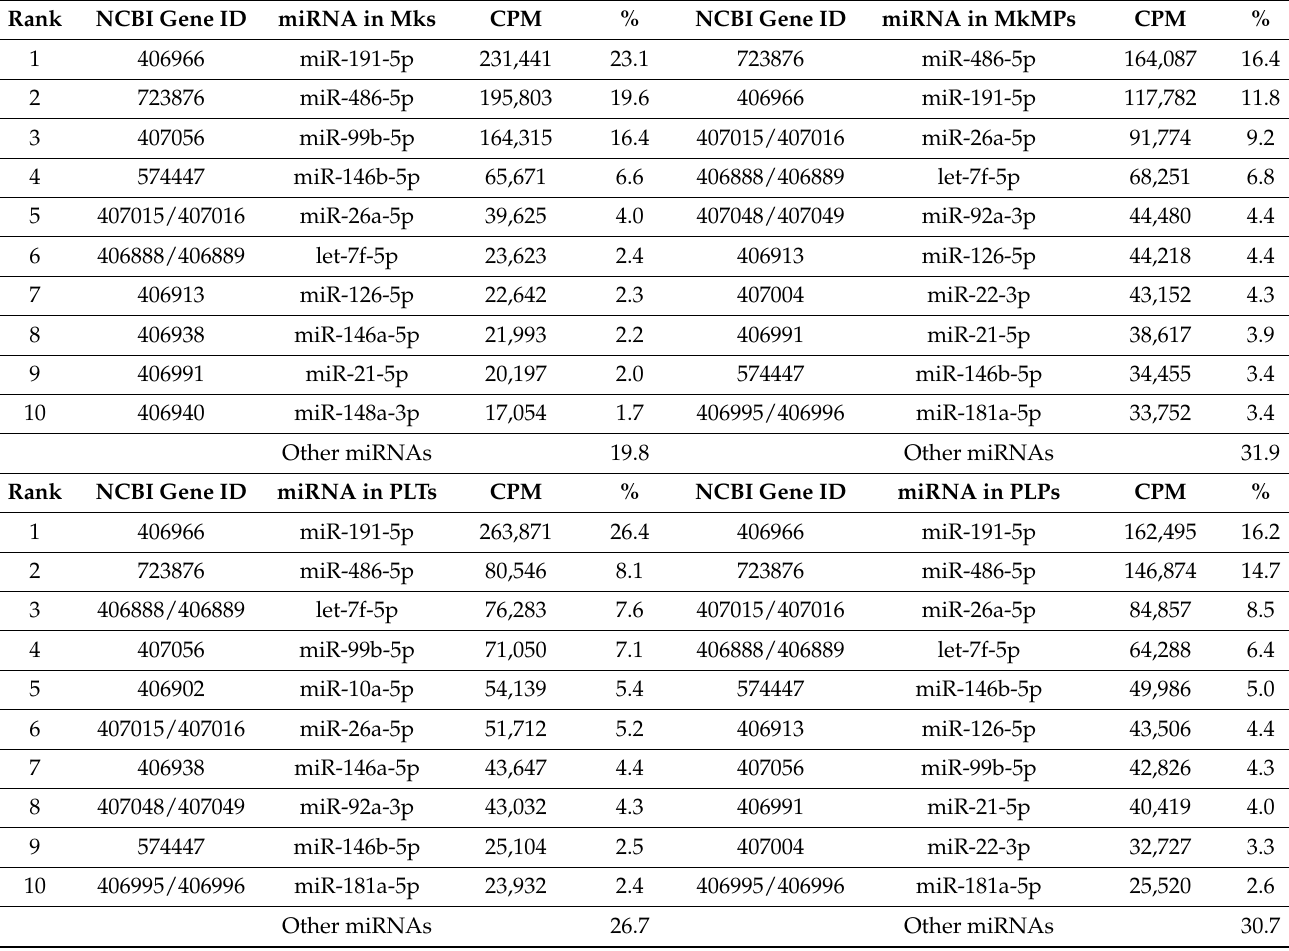
Table 1. The top 10 most abundant miRNAs in MkMPs, Mk cells, PLTs, or